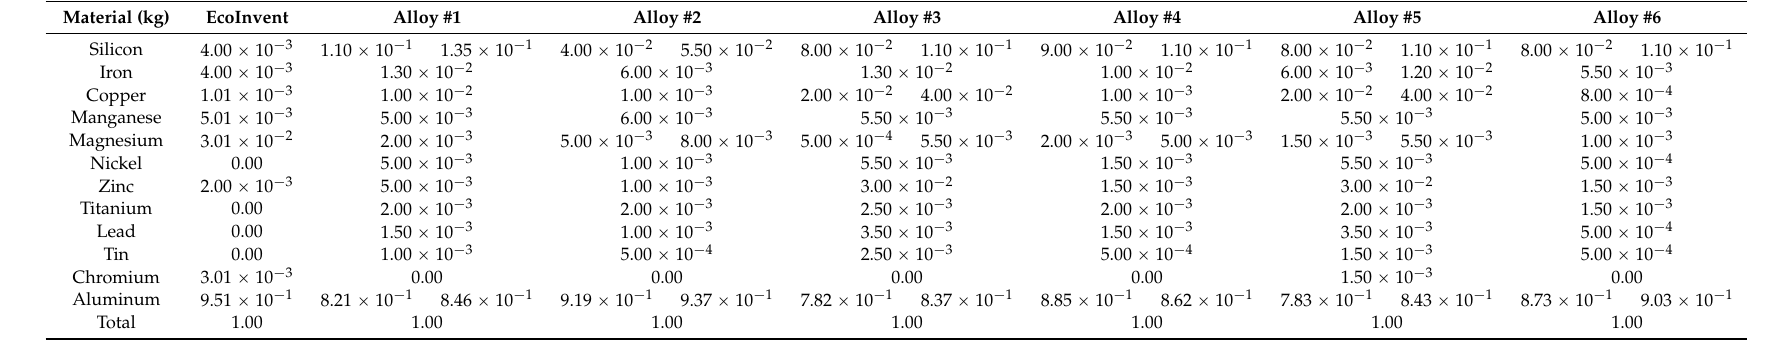
Table 3. Material composition for 1 kg of aluminum